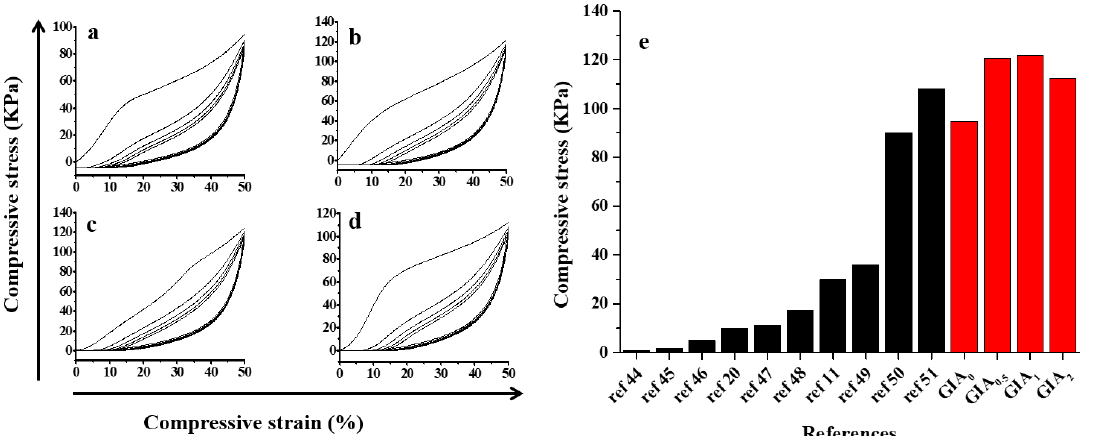
Figure 2. Mechanical properties of GIAs. Cyclic stress–strain curves of GIA 0 ( a ), GIA 0.5 ( b ), GIA 1 ( c ) and GIA 2 ( d ) at the strain of 50% for 5 cycles. Maximum compressive strengths of different aerogels (sponges) at 50% cyclic compression strain ( e ).